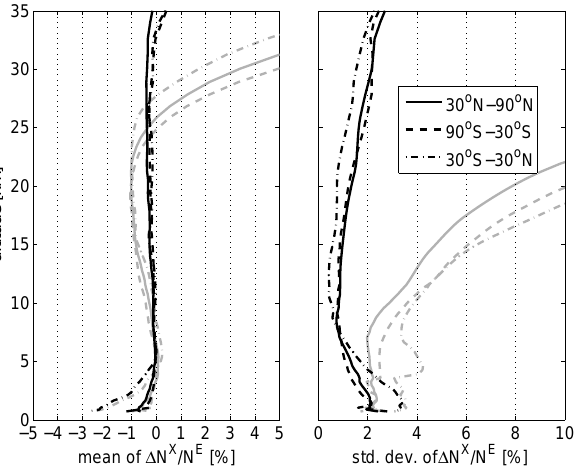
Fig. 4. C/A code SNR values at a line-of-sight altitude of 40 km versus the azimuth angle of the corresponding observation. The figure shows 3182 occultation events recorded by IGOR (TerraSAR-X) between 7 and 27 August 2008 marked in red. For comparison 3034 events recorded by BlackJack (CHAMP) during the same time period are shown (blue dots). The green line is derived from the theoretically expected occultation antenna’s gain function.